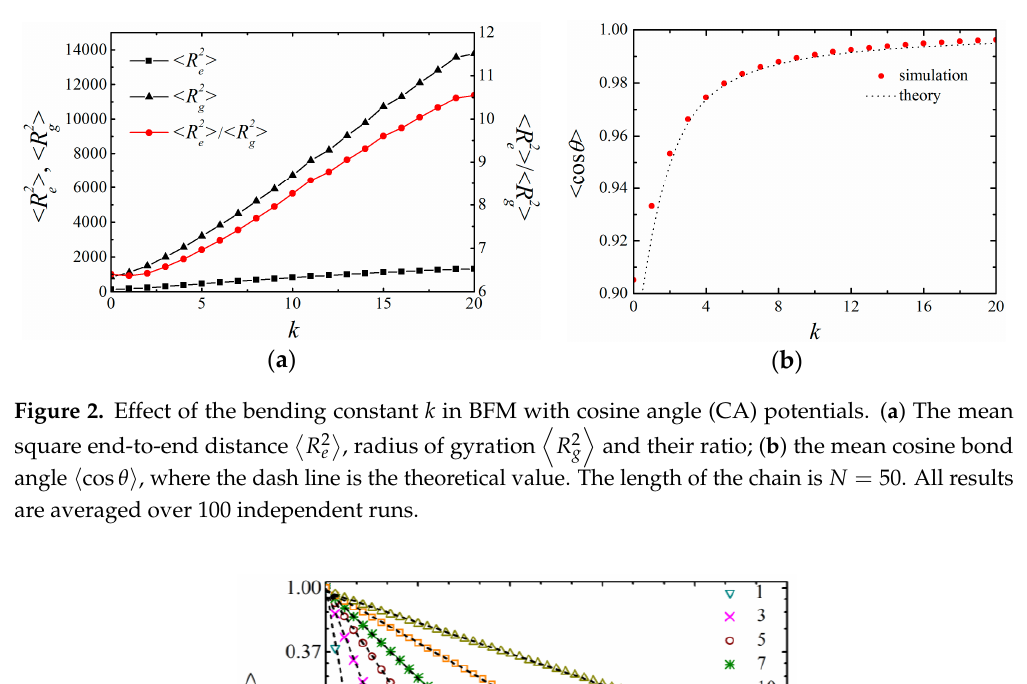
Figure 2. Effect of the bending constant k in BFM with cosine angle (CA) potentials . ( a ) The mean square end-to-end distance 〈𝑅 𝑒2 〉 , radius of gyration 〈𝑅 𝑔2 〉 and their ratio; ( b ) the mean cosine bond angle 〈cos𝜃〉 , where the dash line is the theoretical value. The length of the chain is 𝑁 = 50 . All results are averaged over 100 independent runs.